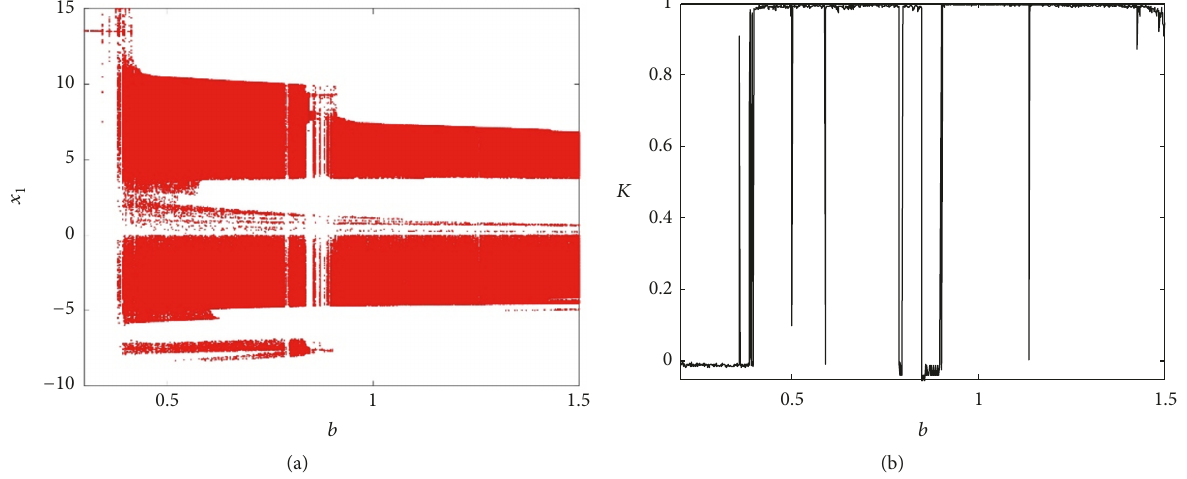
Figure 2: (a) Displacement. (b) Phase plane.